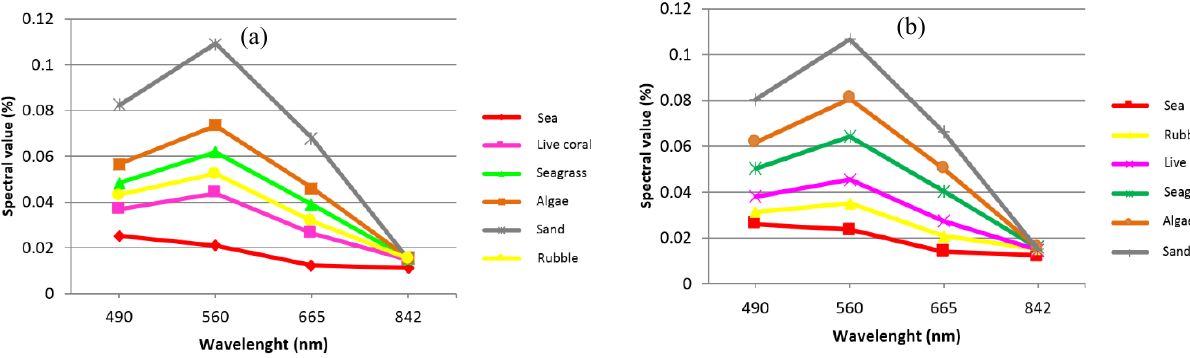
Figure 7. Spectral reflectance pattern of shallow water habitat based on IsoData and K-Means method on Sentinel-2 images, (a) Spectral reflectance pattern with IsoData method, (b) Spectral reflectance pattern using K-Means